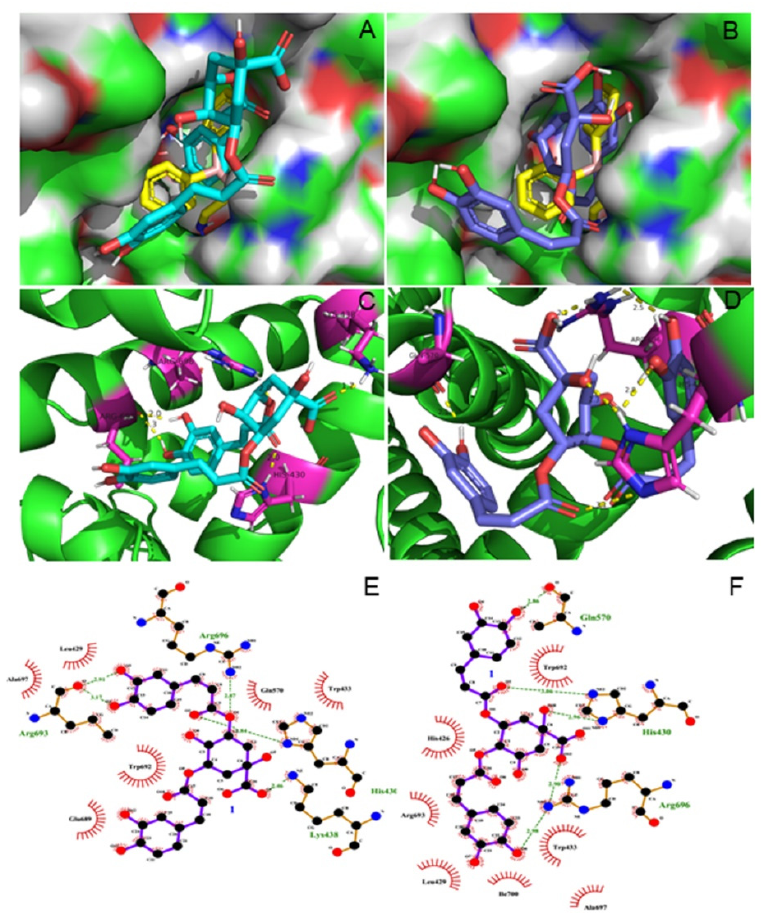
Figure 3. Docked conformations of isochlorogenic acid ( A ), isochlorogenic acid ( B ), and agonist 2-APB with cyan, slate, and yellow sticks into the active site of 6MHO protein, respectively ( A , B ). Analysis of molecular docking showing the key interactions in the binding pocket. The key residues are presented in the form of purple sticks, and hydrogen bonds are drawn with dotted yellow ( C , D ). Ligplot + of isochlorogenic acids A and B bound to 6MHO protein showing the key hydrophobic interactions ( E , F ).